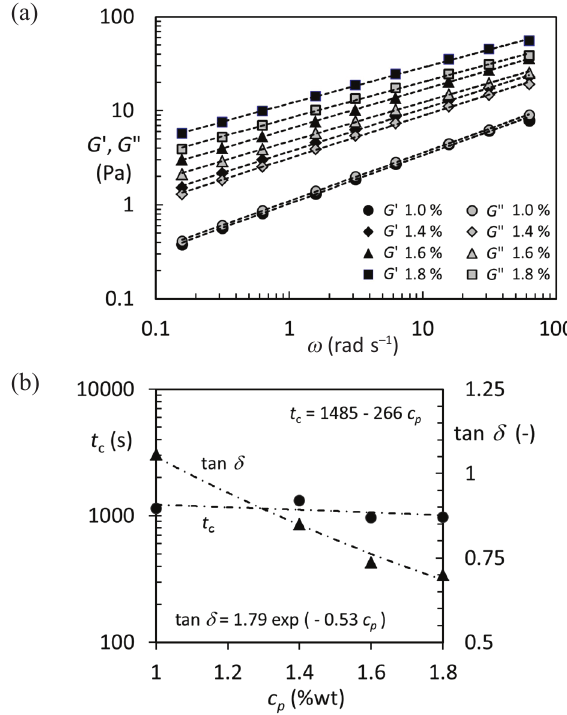
Fig. 7 – a) Mechanical spectra at sol-gel transition. Sym- bols: 1.0 %wt (circles), 1.4 %wt (triangles), 1.6 %wt (dia- monds), and 1.8 %wt (squares); G' (black) G'' (grey) b) con- centration dependence of the loss tangent and the crossover time t obtained from the application of the Winter-Chambon cr criterion.